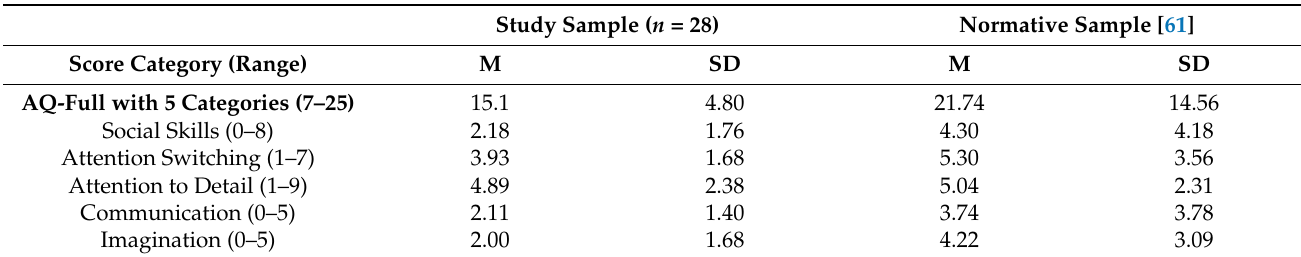
Table 1. A detailed description of the Autism Quotient scores, which can be subcategorised into 5 domains as originally designed [49]. Normative values report from an Australian sample of AQ with 5 domains [61], adapted with permission from [61], Copyright © 2013 J. Broadbent et al. Study Sample ( n = 28)